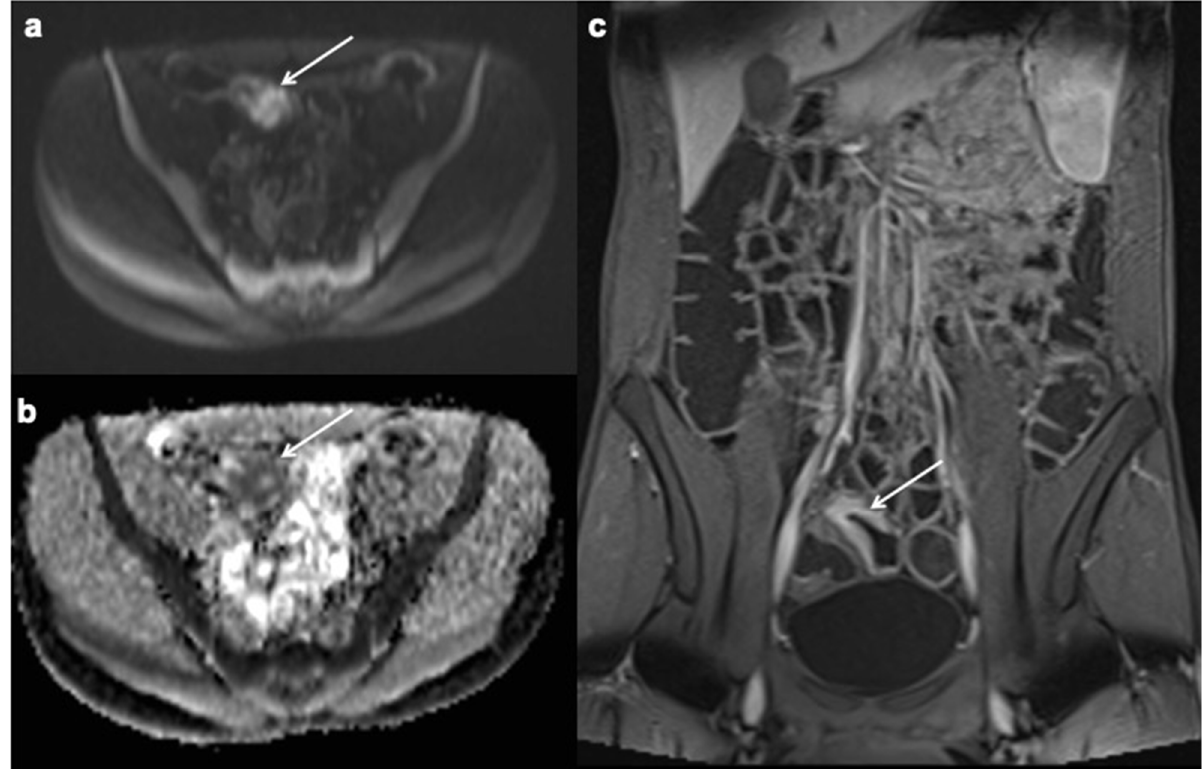
Figure 6. Restricted diffusion. Axial diffusion-weighted (b = 800 s/mm 2 ) ( a ), ADC map ( b ) MRE images in patient with CD detect marked bowel wall diffusion restriction in the terminal ileum. This intestinal segment has hyperintense signal (arrow in ( a )) on the diffusion-weighted image, hypointense signal (arrow in ( b )) on the ADC map and mural hyperenhancement in contrast-enhanced fat suppressed T1-weighted portal venous phase ( c ) (white arrows).